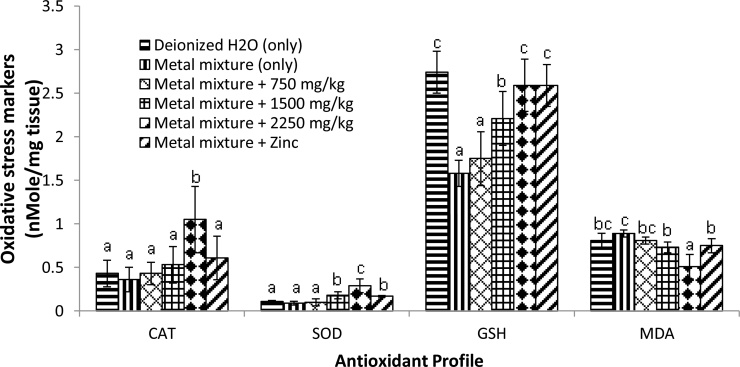
Effect of Costus afer and zinc on oxidative stress markers of the frontal cortex of the brain of male albino rats treated with heavy metal mixture. Values with different superscripts (a, b, c) were significantly different from each other (p <  0.05) and those with the same superscripts were not significantly different.